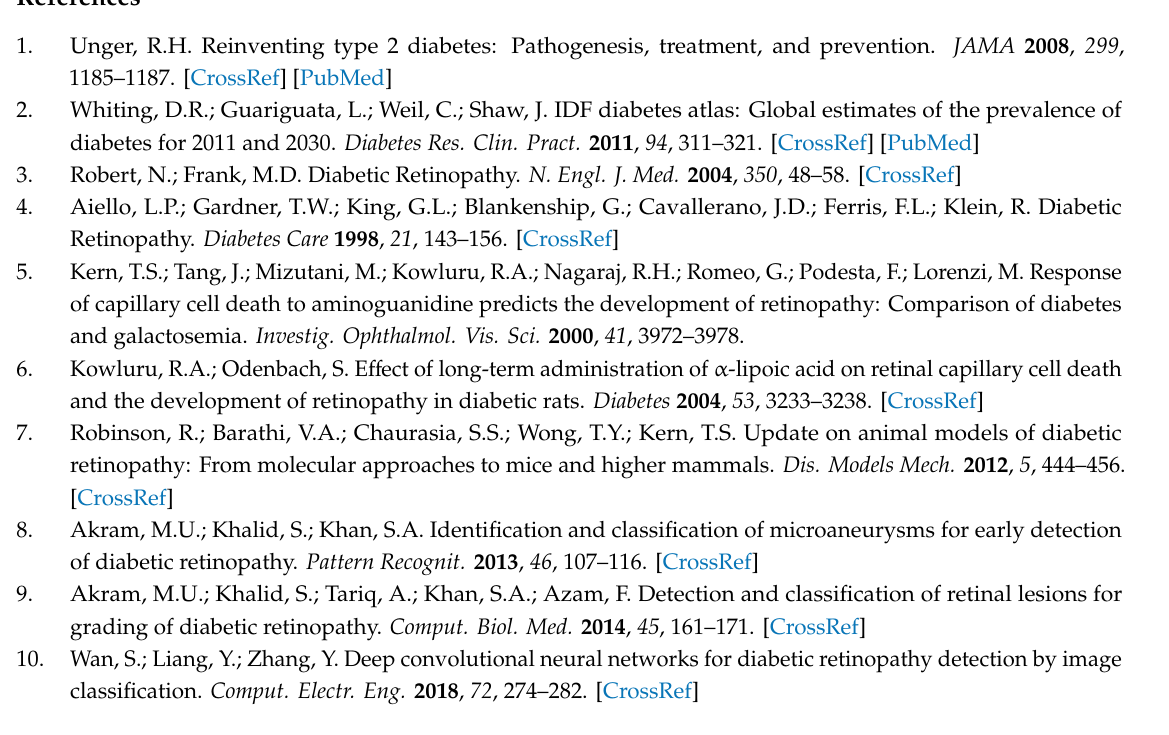
Figure S1: An image of the Zeiss fundus camera. Xe is xenon flash, L1 is concentrator, S1 is observation system light source, L2-7 is photographic system optics, BS is beam splitter, f is filter, M1-4 is mirror, F is camera negative, R is targeting, and the dotted and solid lines are the light source input and observation paths, respectively. Figure S2: Traditional OCT architecture. Figure S3: (a) Color retinal image; (b) R channel retinal image; (c) G channel retinal Table S1: Confusion matrix of binary